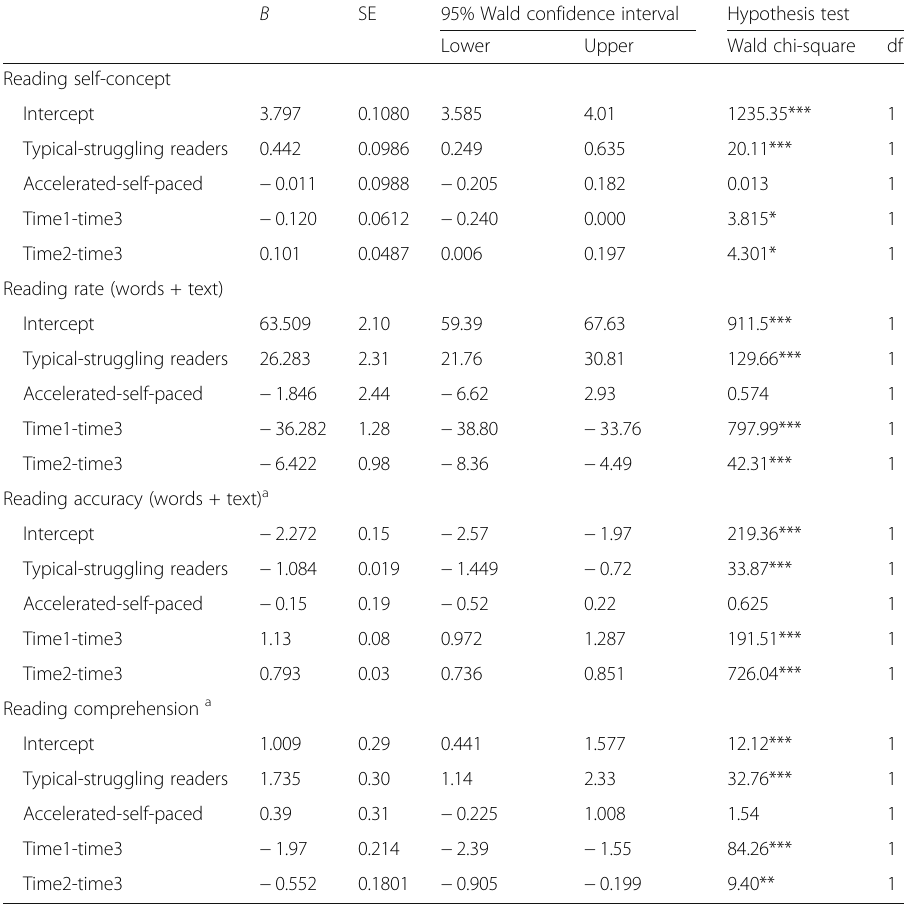
Table 5 Multilevel model: generalized estimating equations (GEE) B SE 95% Wald confidence interval Hypothesis test Lower Upper Wald chi-square Reading